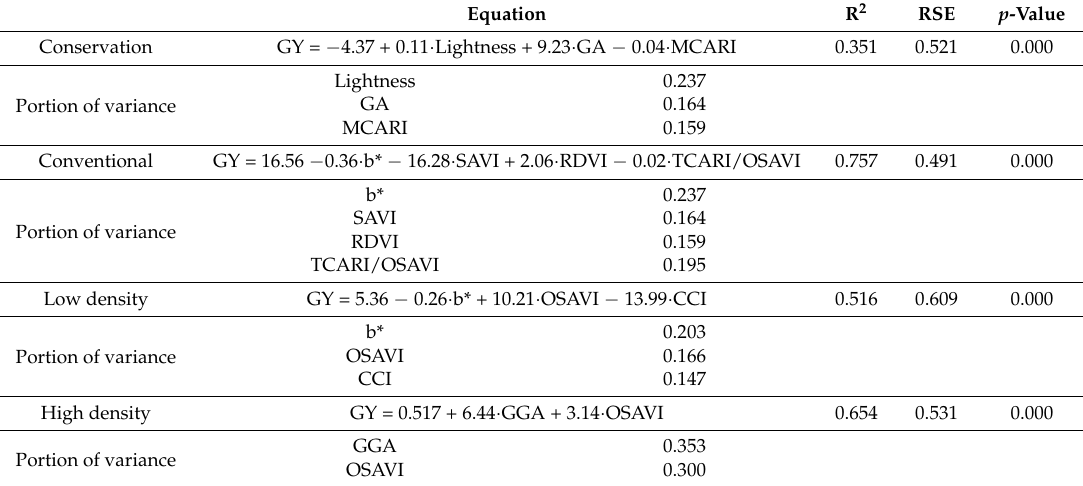
Table 8. Multilinear regression (stepwise) of grain yield (GY) as dependent variable and the remote sensing traits (RGB and multispectral vegetation indexes) measured from the unmanned aerial vehicle as independent variables. These indexes are defined at section Material and Methods. R 2 , determination coefficient; RSE, Residual Standard